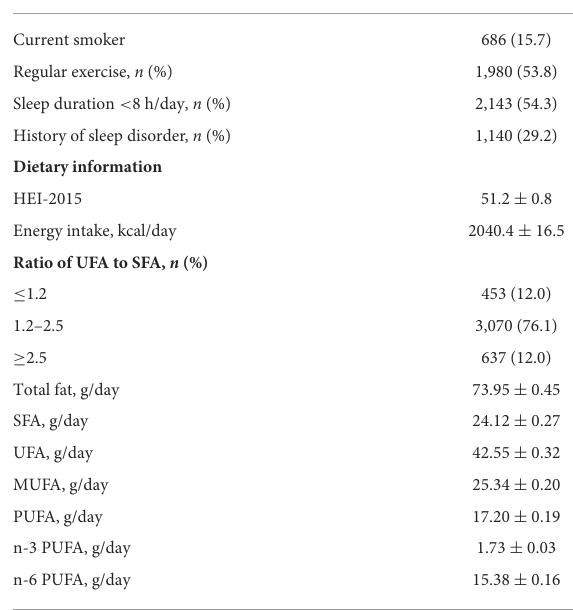
medical conditions and body measurement, lifestyle factors, and dietary information were presented as mean ± standard error (SE) for continuous variables and counts (weighted frequencies) for categorical variables in the